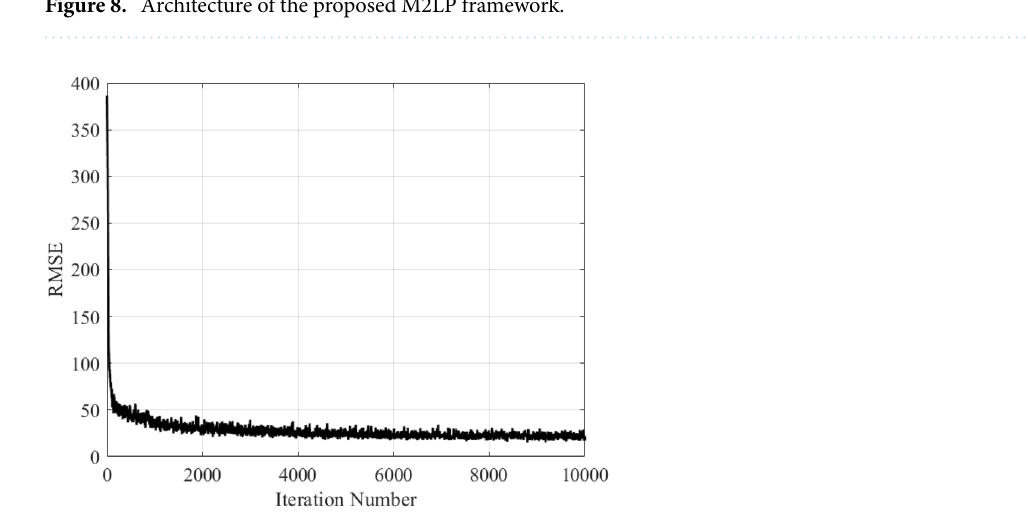
Figure 9. The training history of the proposed M2LP model in terms of RMSE (Root Mean Square Error) versus iteration number.